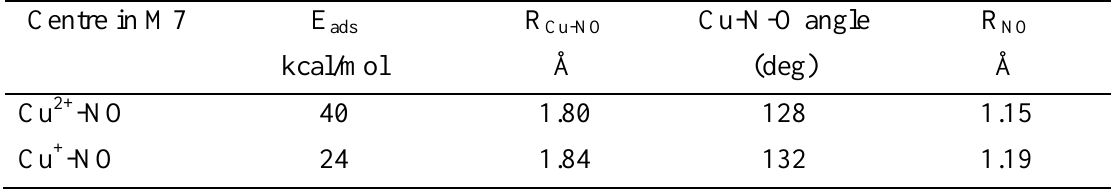
Table 3. Calculated properties of adsorption complexes between NO molecule and CuZSM-5: adsorption energy, equilibrium Cu – NO bond distance and angle, intramolecular NO bond